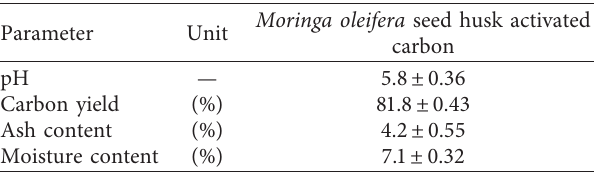
Table 2: Physicochemical parameters of Moringa oleifera seed husk activated carbon.